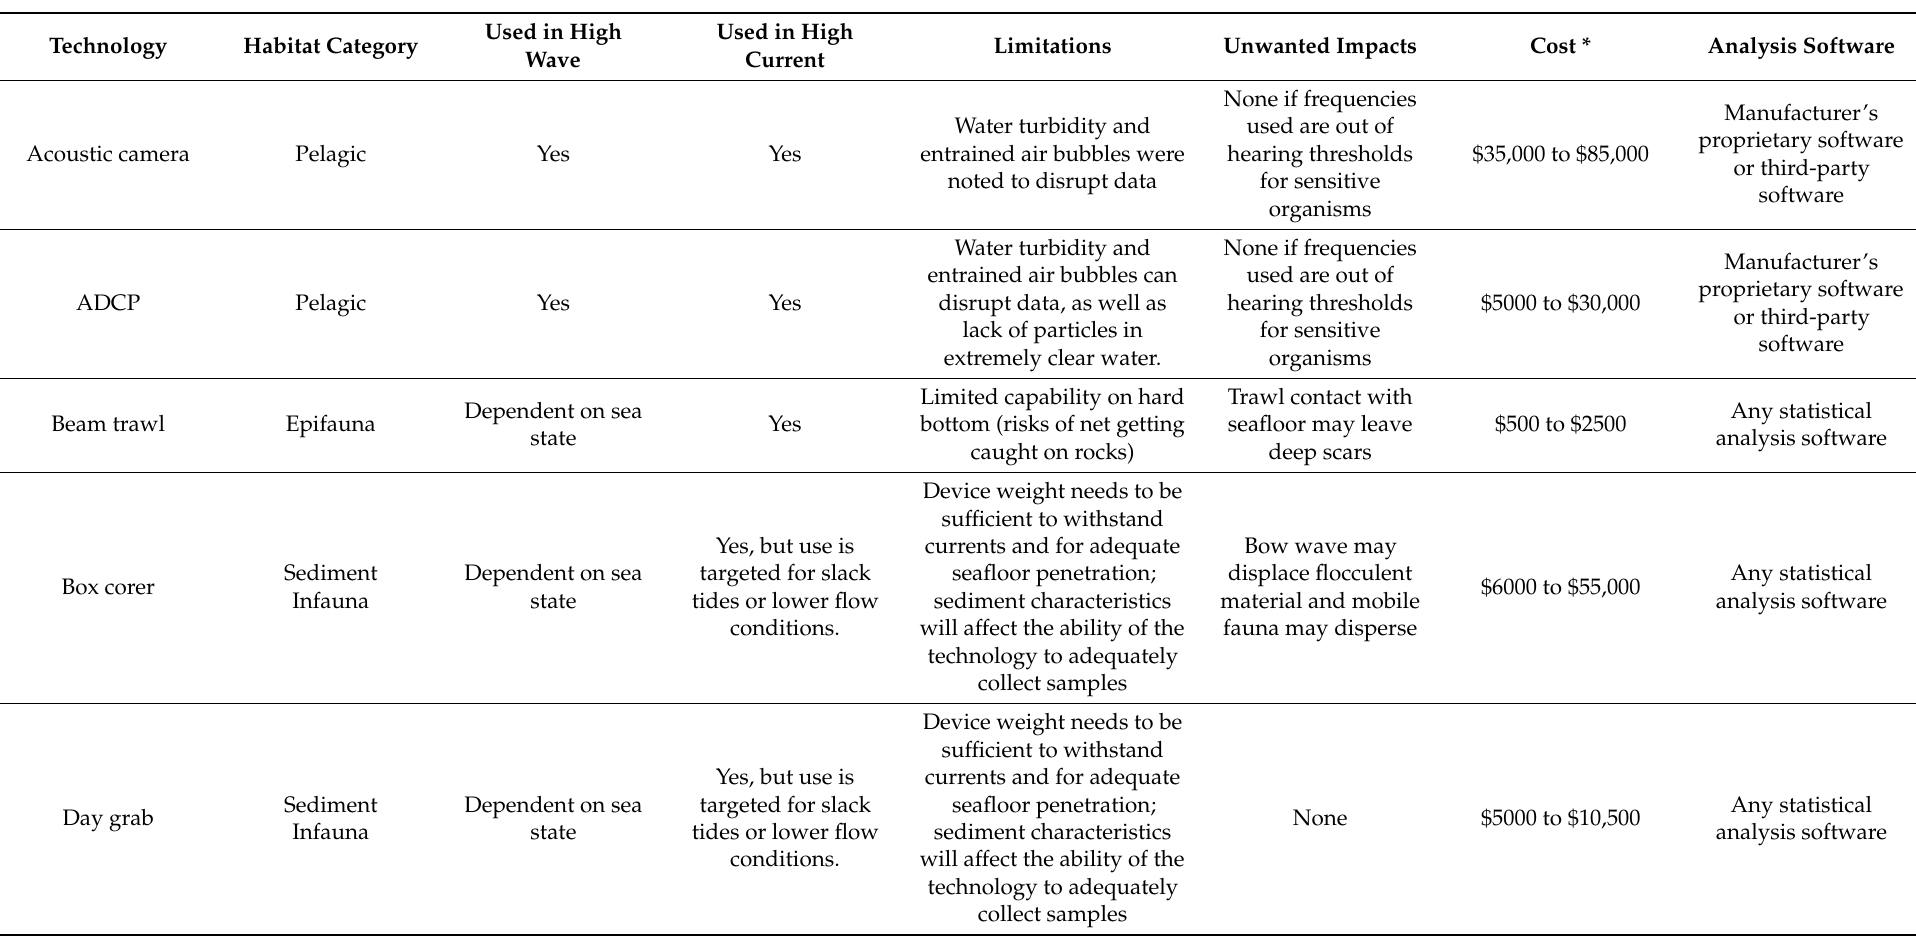
Table 5. Applicability to marine energy project sites of the most frequently used technologies for each of the six habitat categories. Multiple technologies were used across several habitat